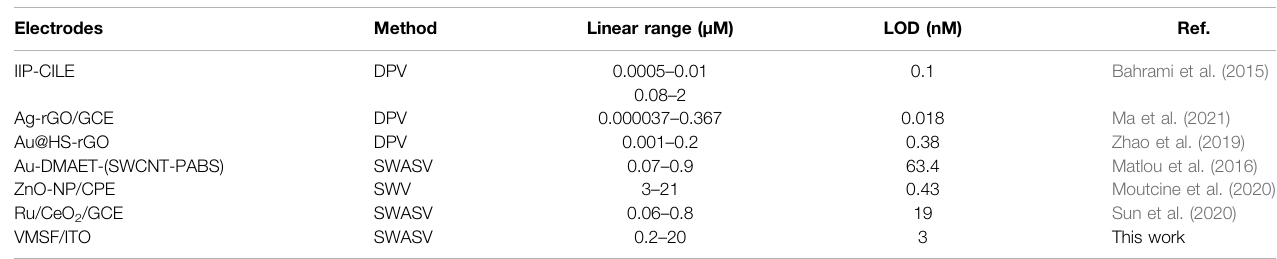
TABLE 1 | Comparison of the analytical performances of various electroanalytical methods for the determination of Hg 2+ . Electrodes Method Linear range ( μ M) LOD (nM) Ref.